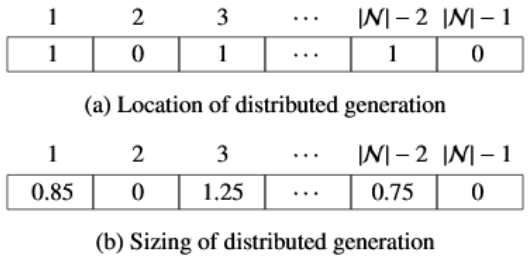
Figure 1. Codification strategy for the location and sizing of distributed generators (DGs) in direct current (DC)